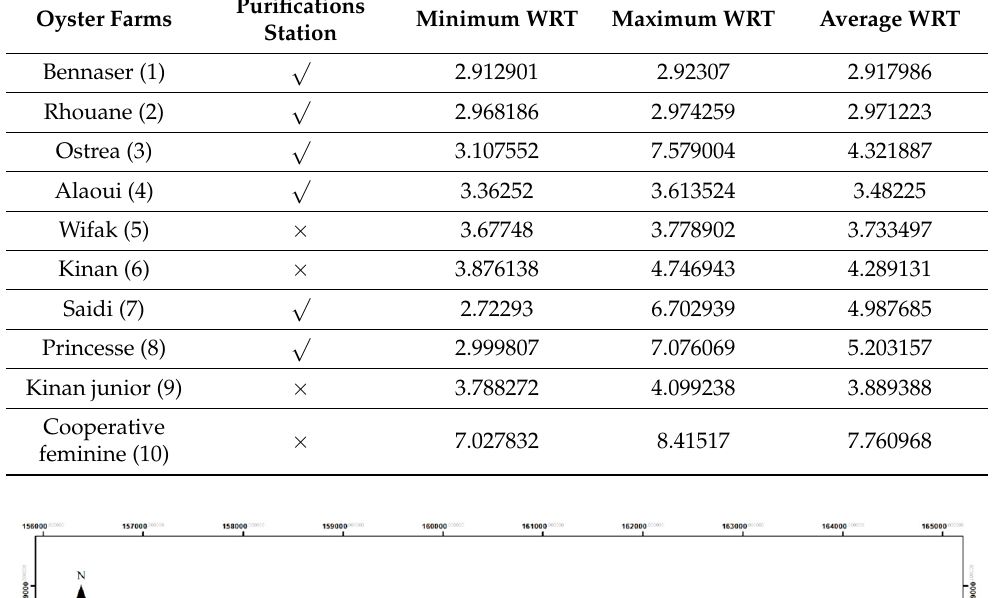
Table 4. Aquaculture activity distribution of farms oyster locations, production and the MIN, max and average WRT in their concession locations.